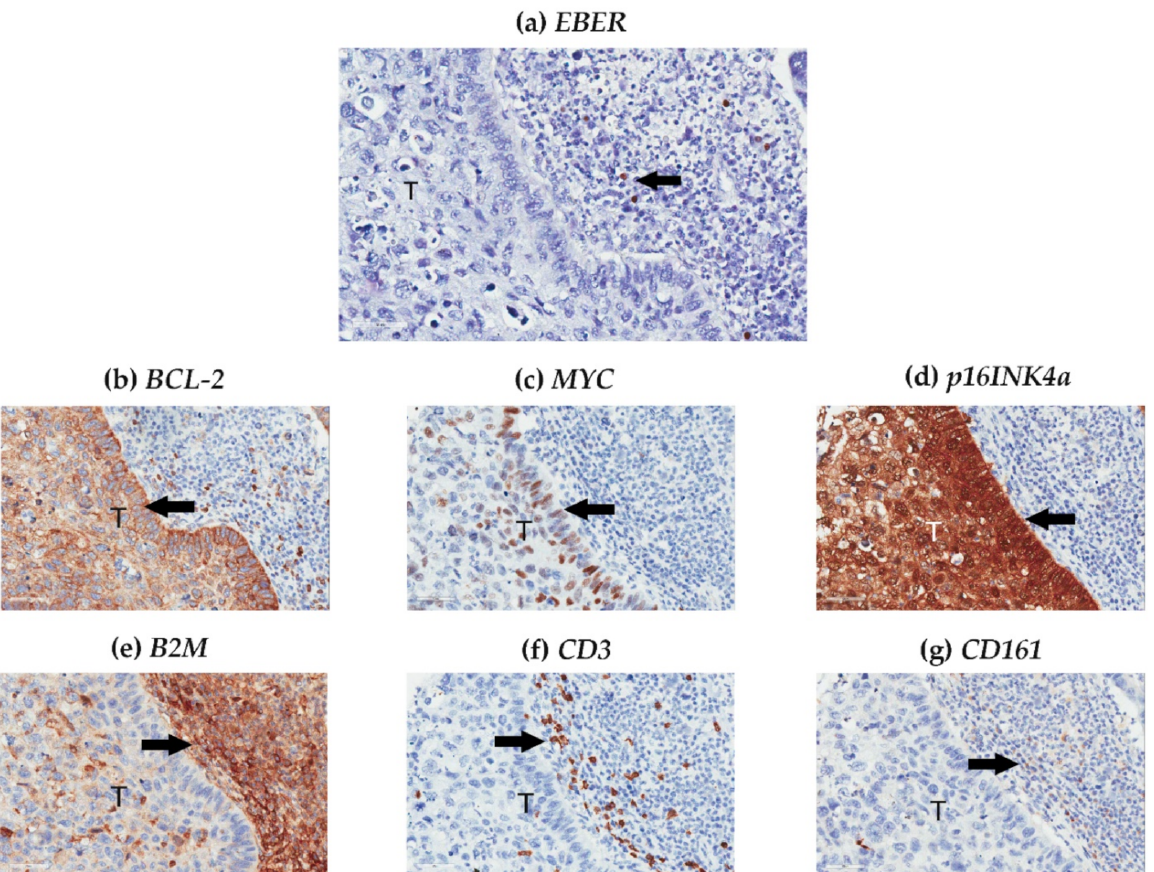
Figure 2. Evaluation of Epstein–Barr virus-encoding RNA ( EBER ), BCL-2 , MYC , p16INK4a , B2M , CD3 , and CD161 in a representative case with laryngeal squamous cell carcinoma. ( a ) EBER signals (arrow) were detected using in situ hybridization in the nuclei of tumor-infiltrating lymphocytes. Expression of tumor markers, including ( b ) BCL-2 , ( c ) MYC , and ( d ) p16INK4a (arrows), occurred predominantly in intratumoral cells, whereas expression of immunological markers, including ( e ) B2M , ( f ) CD3 , and ( g ) CD161 (arrows), occurred mainly in peritumoral cells. Original magnification 40 ×